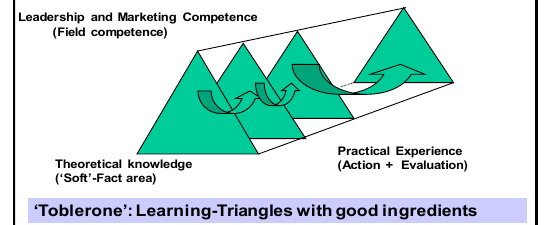
Figure 1: The ‘Toblerone-Model’ - figure based on Schmid